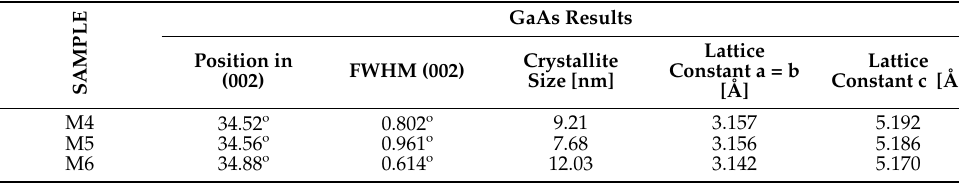
Table 3. Parameters of nitriding samples on Si substrates.